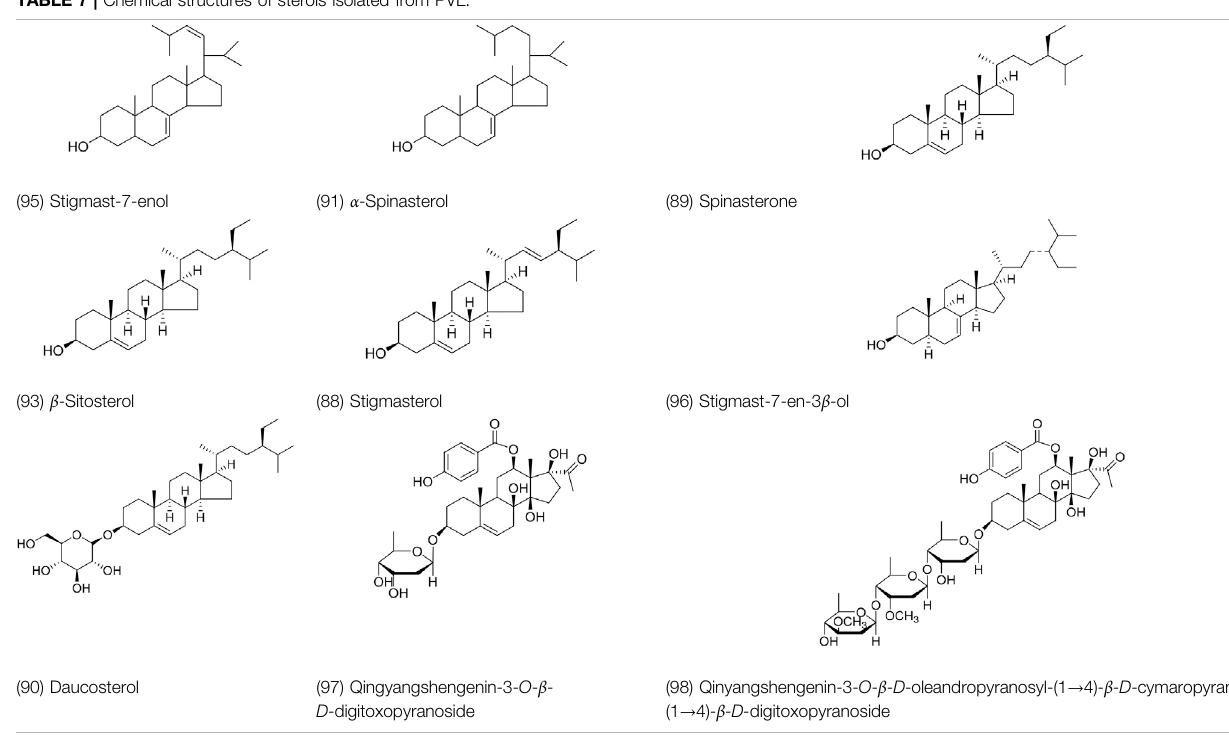
TABLE 7 | Chemical structures of sterols isolated from PVL.